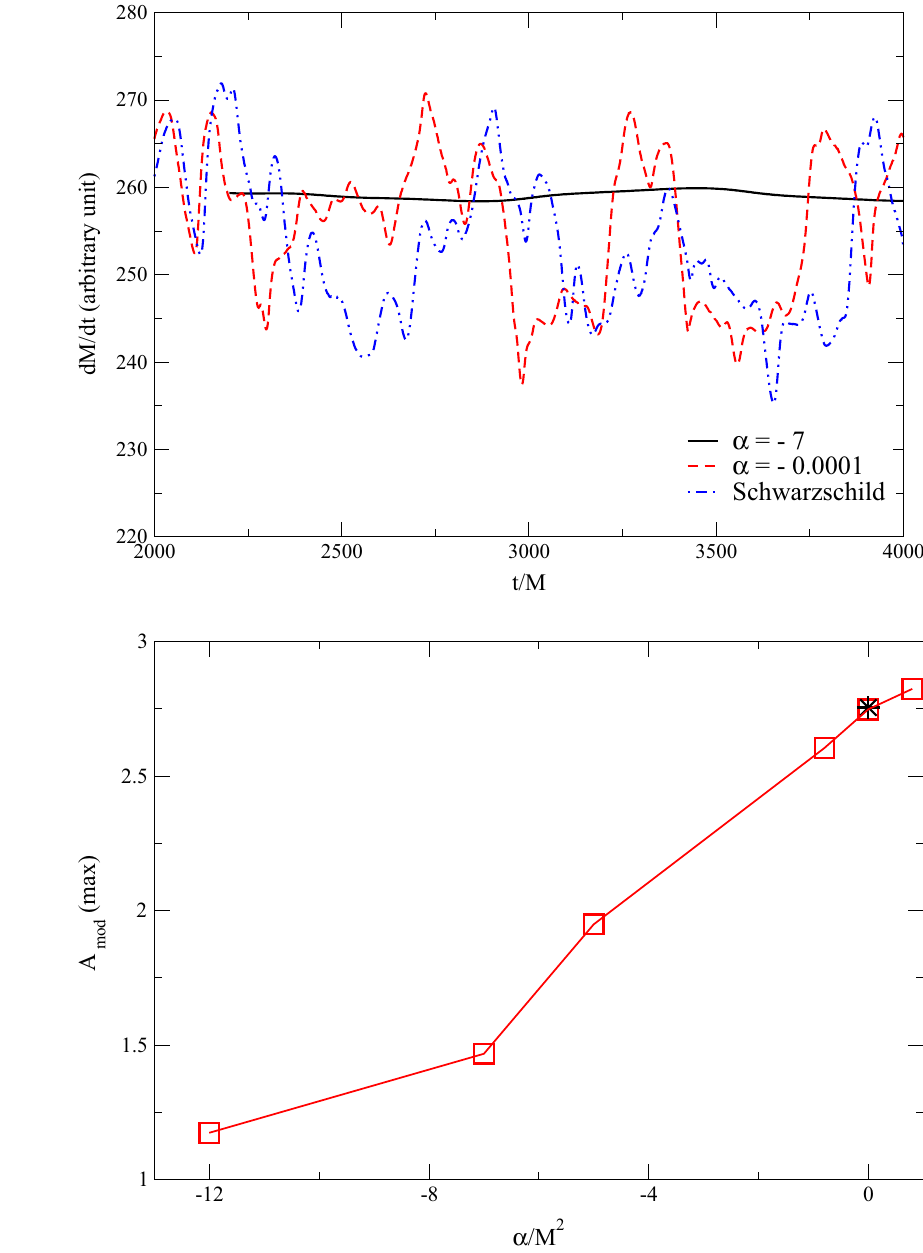
Fig. 9 Comparison of the mass accretion rate for α = − 7 and − 0 . 0001 with Schwarzschild solution as a function of time. The mass accretion rates are plotted after the shock cone reaches to the steady state